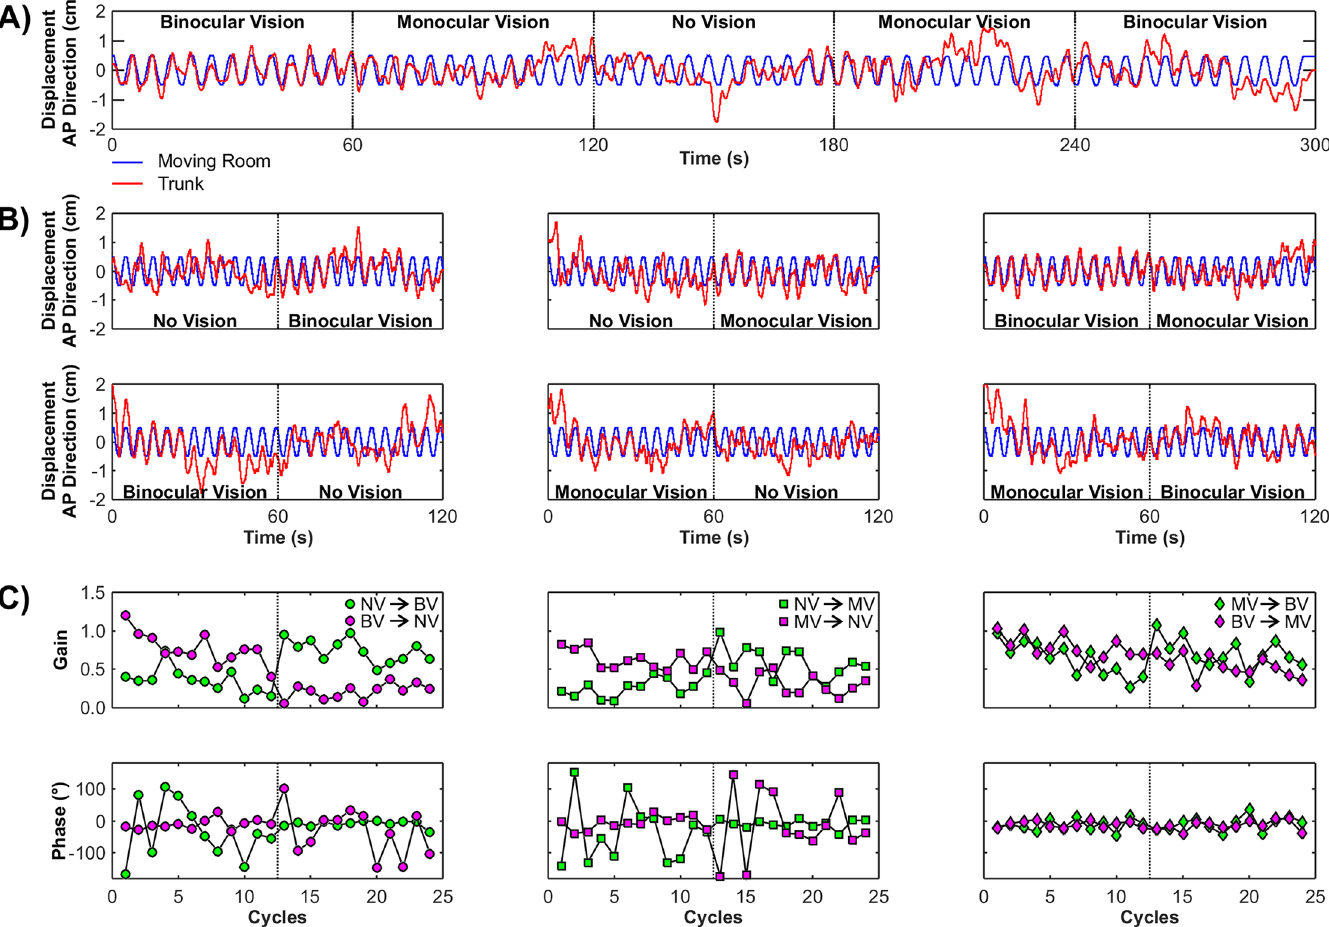
Fig 2. Example of time series for one participant for all visual transitions. A) Time-series for one participant showing room movement (blue line) and body sway (red line) in condition 3. B) Time-series of part of the whole trial duration (i.e., 120 s) illustrating all of the visual transitions investigated in the present study. This data is for the same participant of part A. C) Cycle-by-cycle gain (top) and phase (bottom) values for one participant (same as in parts A and B) in the different combination of visual transitions. Vertical dashed lines indicate visual transitions. [BV: binocular vision | NV: no vision | MV: monocular